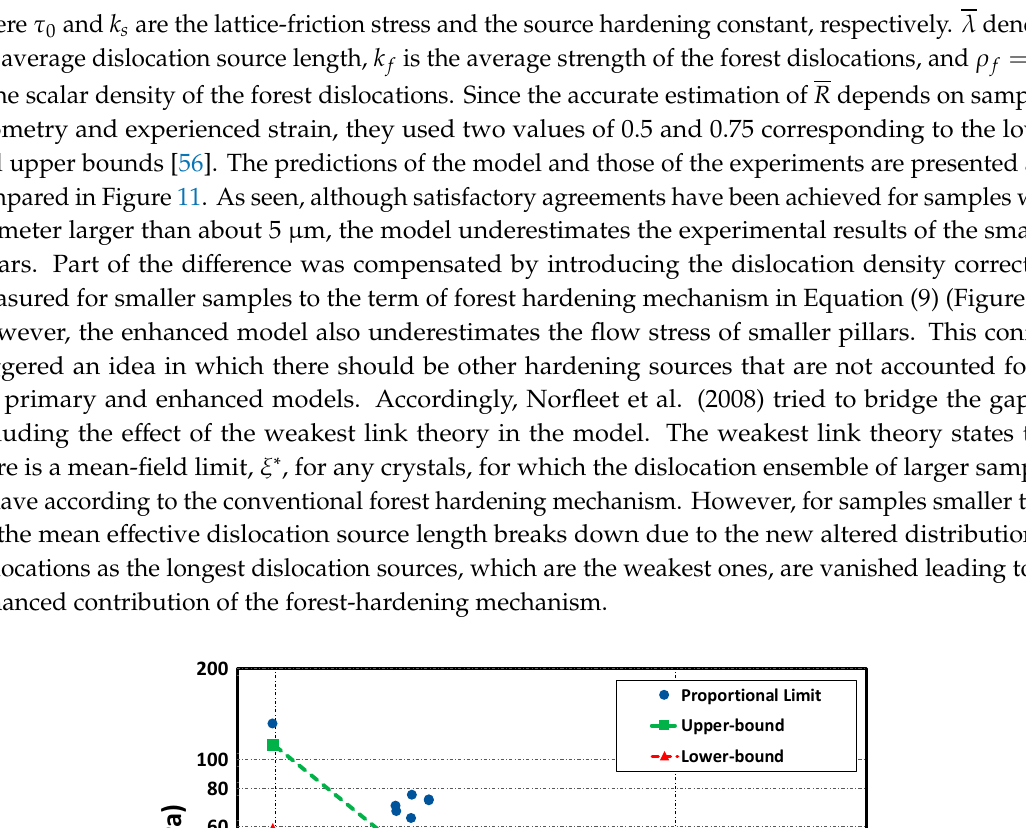
Figure 12. A comparison between the lower and upper bounds of Equation (9) corrected by increasing the dislocation density at smaller samples with the experimentally measured proportional limits of Ni micropillars (after Norfleet et al. [56]). 4. Atomistic Simulation of Micropillar Compression Tests Nowadays, using molecular dynamics (MD), the mechanical response and deformation mechanisms of crystalline materials can be studied with full atomistic details. The MD simulation challenge is its limits on the simulation time and length scales. However, developing new efficient